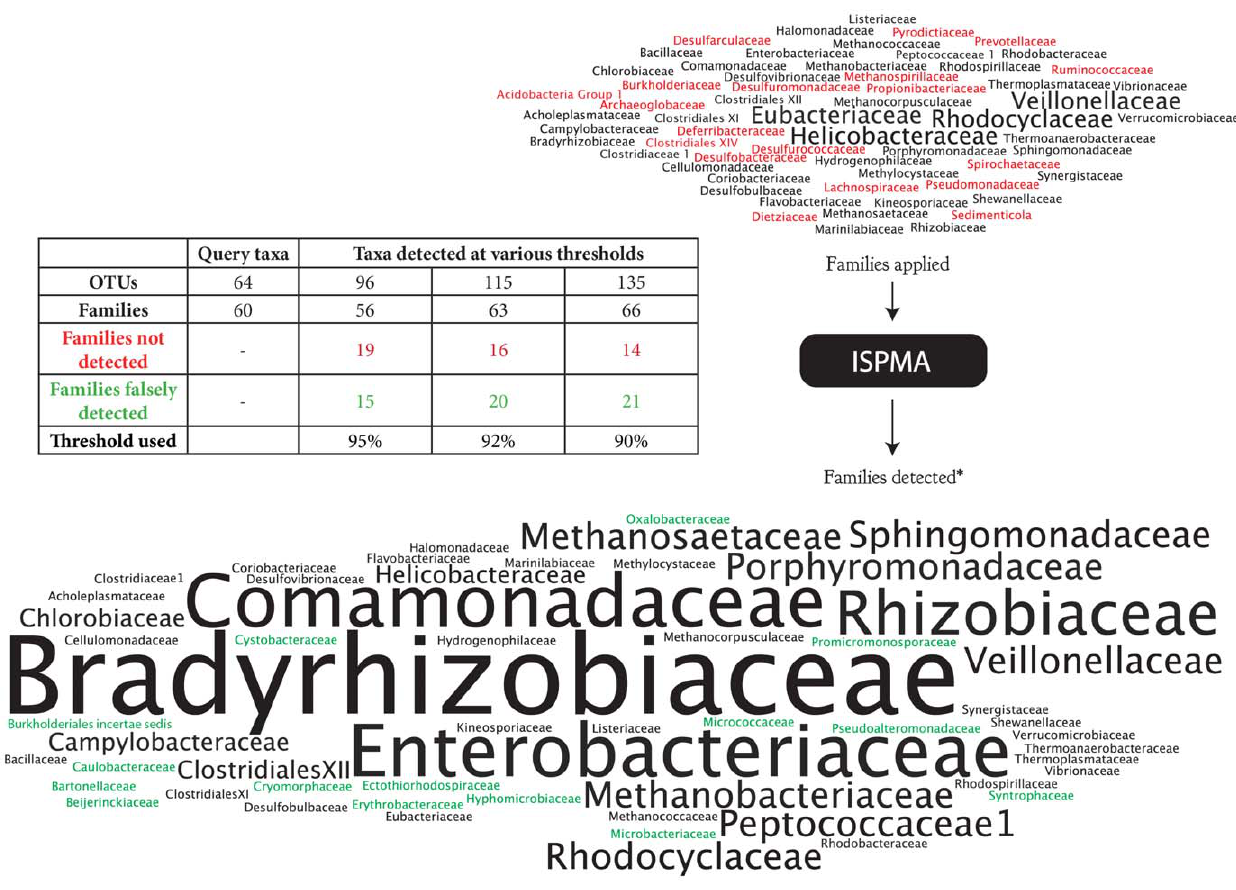
Figure 2. Results of the ISPMA analyses for the 64 OTU ‘sample’. The number of OTUs representing each family is proportional to the font size in this ‘‘Wordle’’ image. The families shown ‘pre-analyses’ (top) are represented by one (smaller text), or two (larger text) OTUs. After analyses, using a 95% detection threshold, however, some families are ‘increased’ in their OTU numbers by an order of magnitude. Families shown in red in the input sample are not present in the output set, families in green font in the output set are not present in the input sample. The inset table also shows the outputs at 90 and 92% detection thresholds.